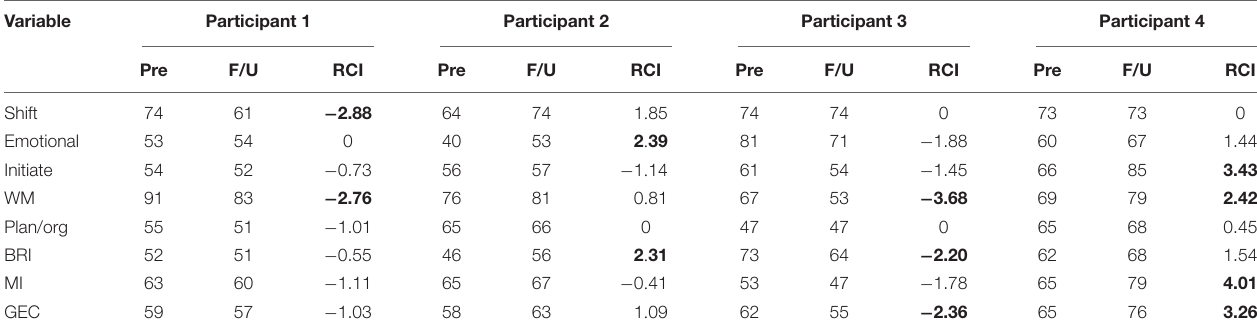
TABLE 4 | Reliable change index for self-reported executive function in daily life (BRIEF-A).